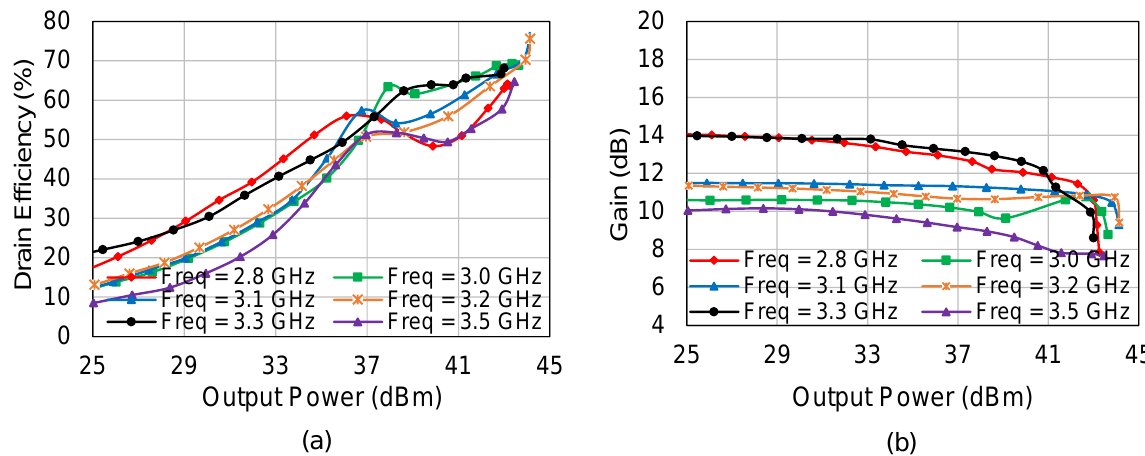
Figure 15. Measured ( a ) drain efficiency and ( b ) gain versus output